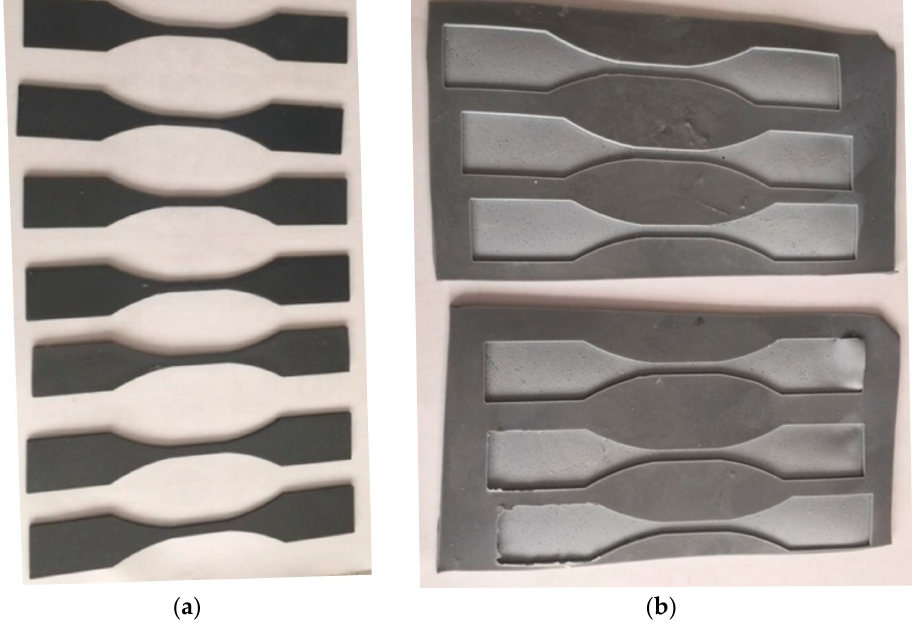
Figure 1. ( a ) Test reference specimens made by 3D printing and ( b ) silicone molds made from Polastosil.